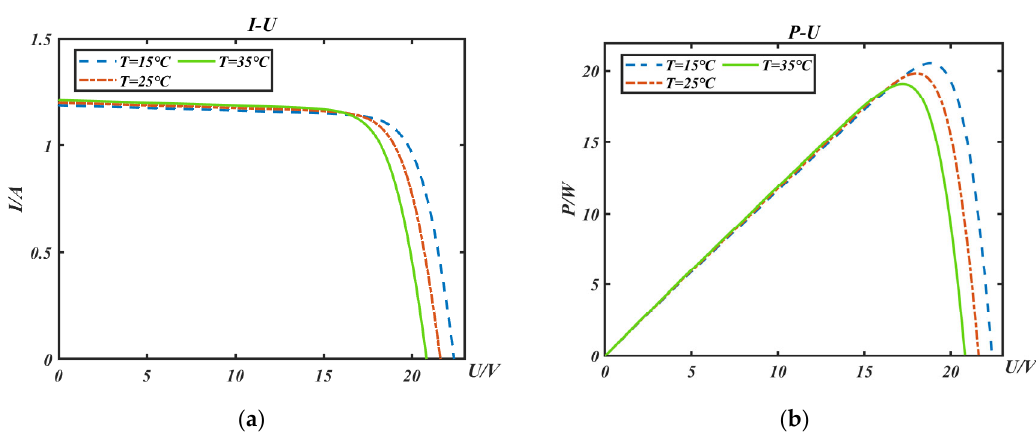
Figure 3. Photovoltaic cell output characteristics curve.